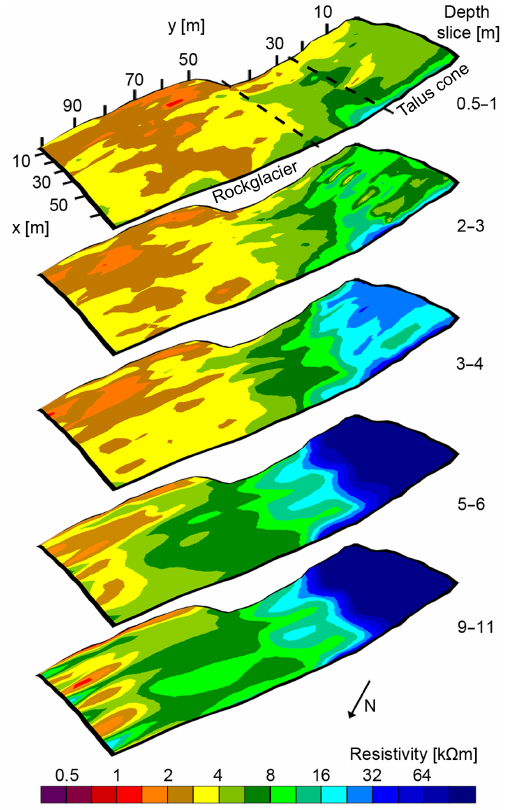
Figure 5. Selected depth slices of the quasi-3-D ERI model for